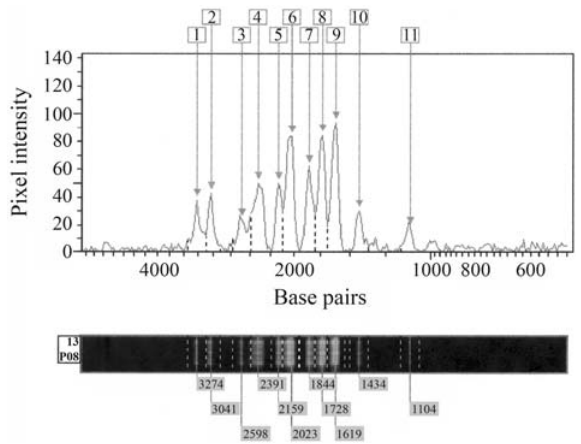
Figure 1 - Random amplified polymorphic DNA marker analysis using the OPA13 primer and one Eupemphix nattereri specimen from Palmeiras municipality. The analysis was made using the Image Master 1D software (Amersham Pharmacia Biotech, USA). The amplicons varied from 1104 to 3274 bp and band intensity ranged from 20 to 90 pixels for eleven am- plified loci.